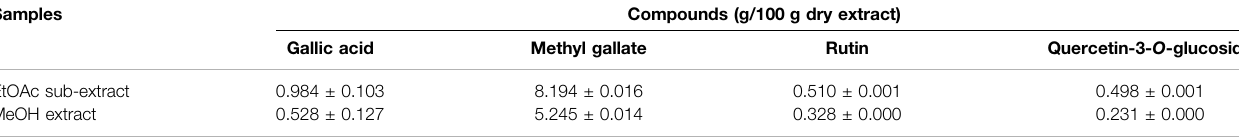
TABLE 6 | Gallic acid, methyl gallate, rutin, quercetin-3- O -glucoside contents of P. atlantica MeOH extract and EtOAc sub-extract.